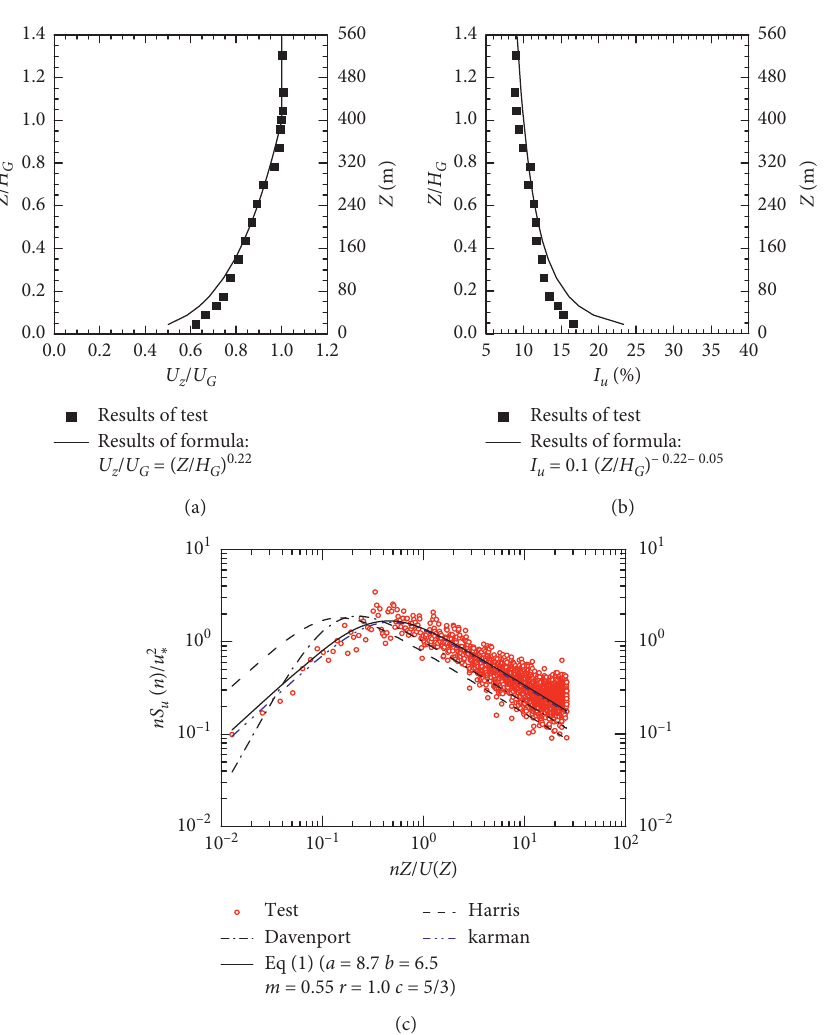
Figure 5: Wind field simulation. (a) Mean wind speed profile. (b) Turbulence profile of along-wind. (c) Fluctuating wind spectrum of along-